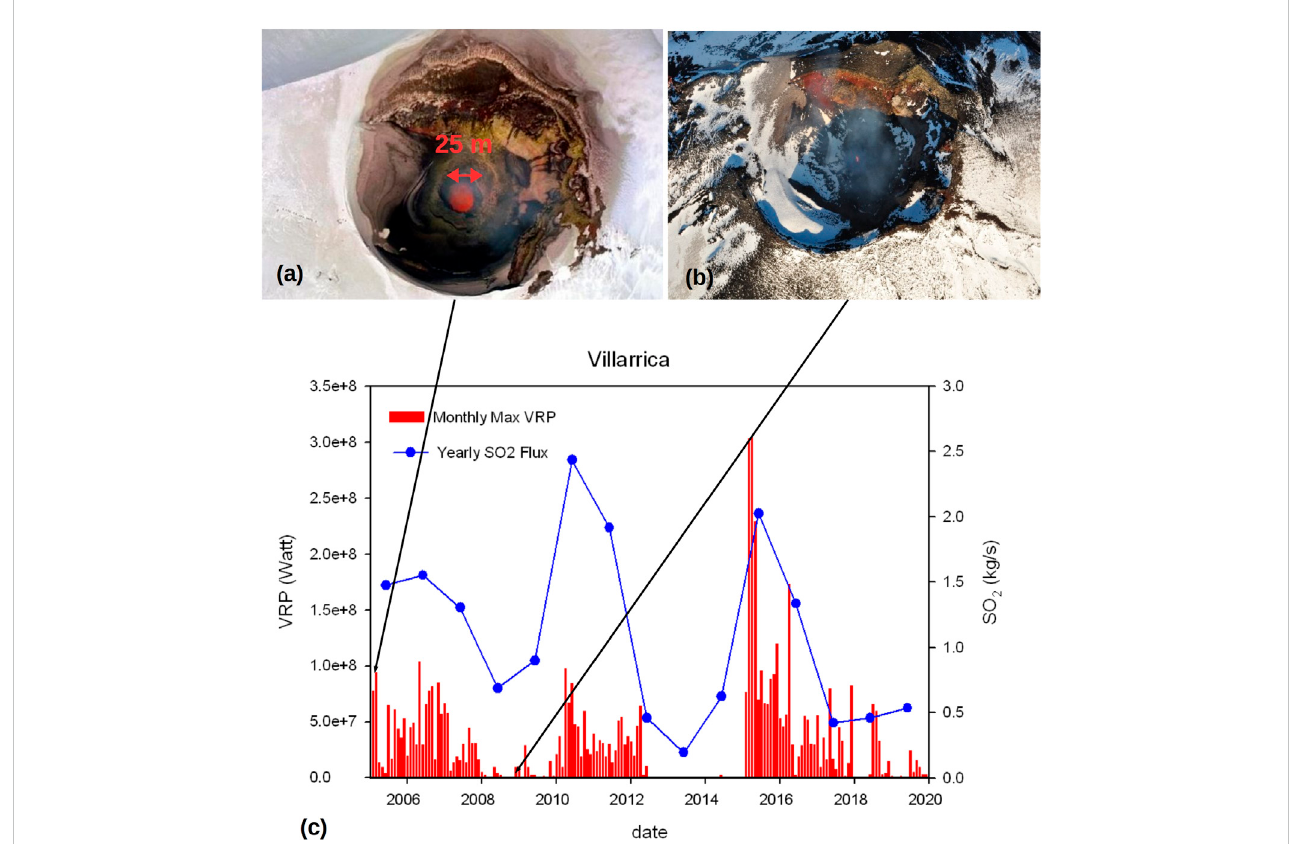
FIGURE 8 LavalakeofVillarricashowslargesizeandactivityvariationsfroma25 mwideboilinglavalake,asin (A) datingfromDecember2004(photo:J.C.Tanguy via GVP), to a narrow glowing hole as in (B) dating from 2009 (photo: T. Dockx). (C) Time series of the yearly averaged SO by the lava lake of